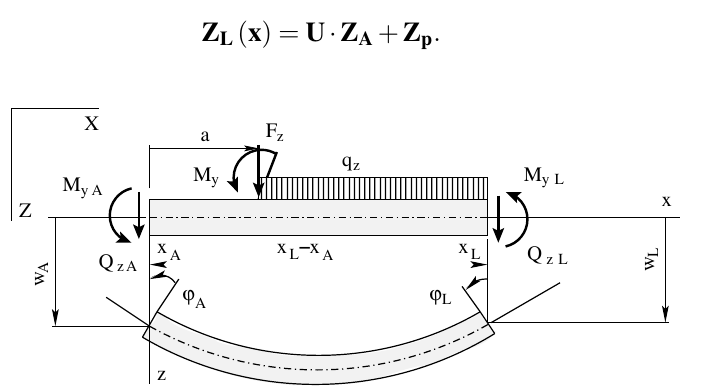
Fig. 2. Beam element with positive direction of displacements, rotations, forces and bending moments.